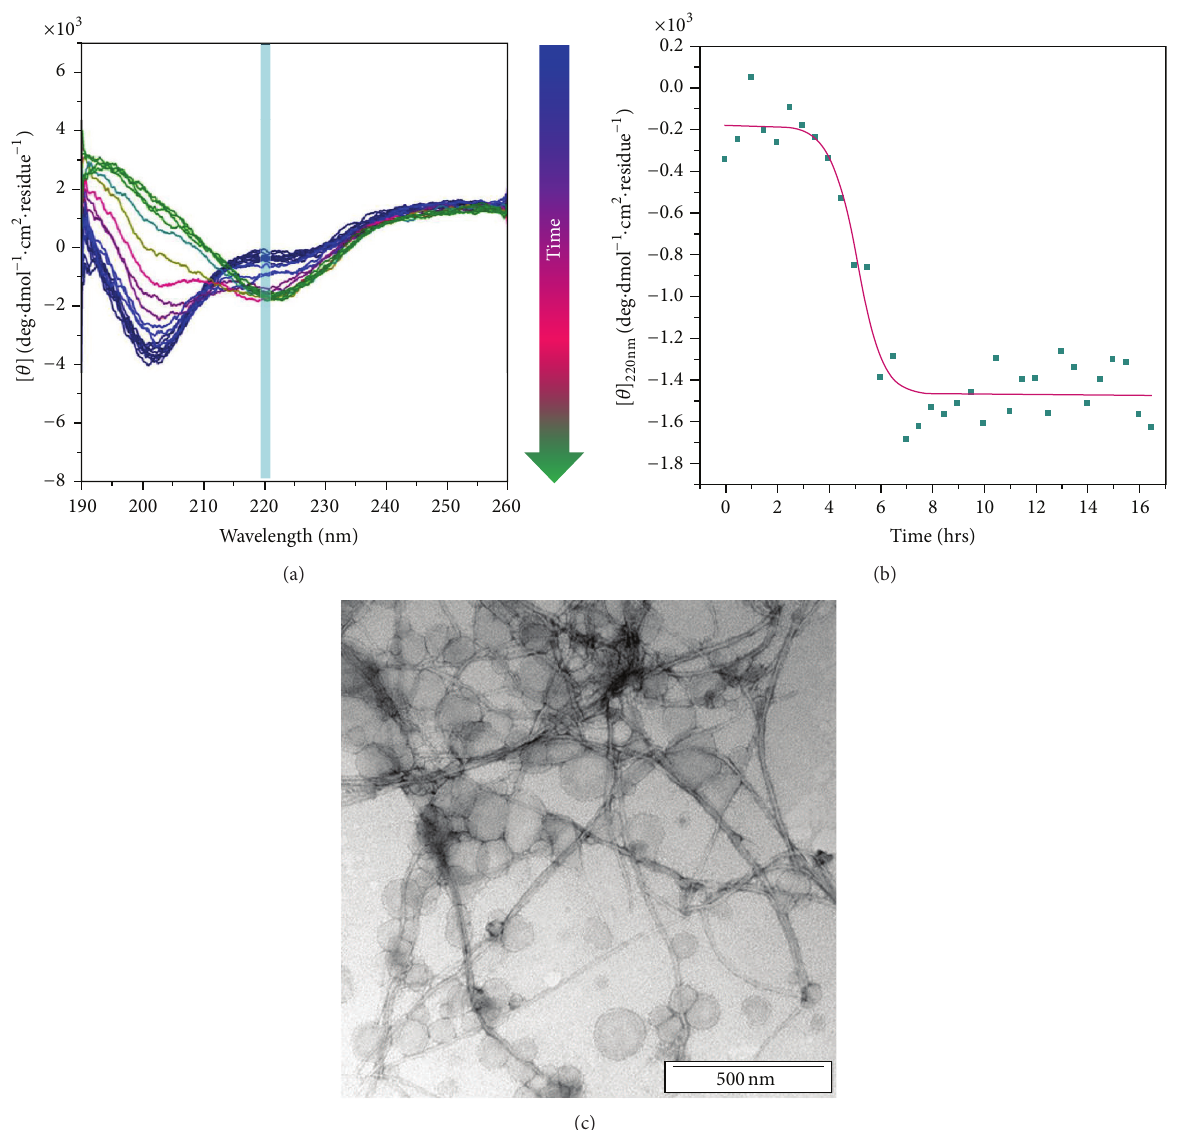
Figure 2: (a) CD kinetic study of hIAPP in vesicles. Plot color code: dark blue: CD spectrum recorded after 5 minutes and green: CD spectrum recorded after few hours. (b) Time course of CD ellipticity at 220 nm. (c) Negatively stained microscopy images of hIAPP after incubation with